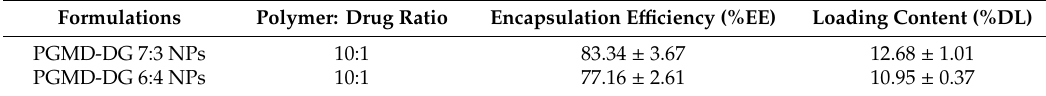
Table3. Representsencapsulationanddrugloadinge ffi ciencyofdiosgeninloadedPGMDnanoparticles. Formulations Polymer: Drug